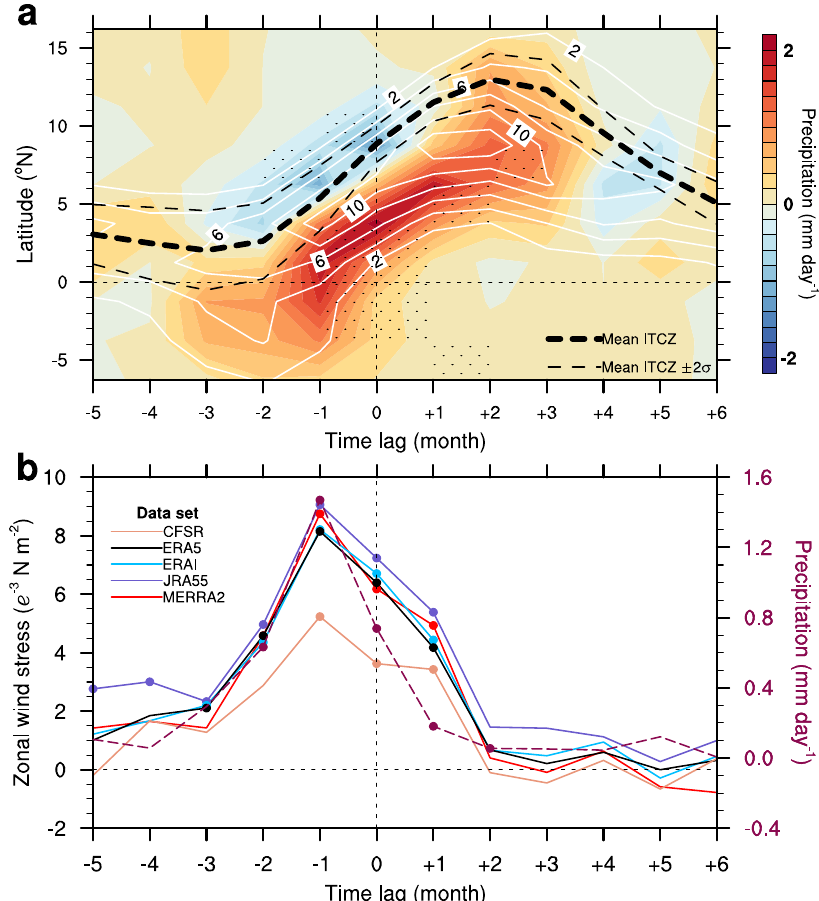
Fig. 3 Related precipitation and zonal-wind stress variability. a Seasonally strati fi ed precipitation anomalies along 20°W regressed on the June (lag = 0) normalized Atl3 SST index (that is, average in the region 3°N – 3°S, 0° – 20°W). Stipples denote statistical signi fi cance at the 95% con fi dence level. The white contours show the climatological-mean precipitation, at interval of 2 mm day − 1 . The dashed black curves denote the mean inter-tropical convergence zone (ITCZ) de fi ned as the latitude of zero meridional wind stress (thick curve) and its two standard deviations represented by ±2 σ (thin curves). b Right axis, dashed curve: precipitation anomalies averaged over the equatorial Atlantic region (3°N – 3°S, 5°E – 40°W) in all calendar months regressed on the normalized Atl3 SST index fi xed in June (lag = 0). Left axis: zonal-wind stress averaged over the western equatorial Atlantic (3°N – 3°S, 20° – 40°W) in all calendar months regressed on the normalized Atl3 SST index fi xed in June (lag = 0). Circular ticks in b denote statistical signi fi cance at the 95% con fi dence